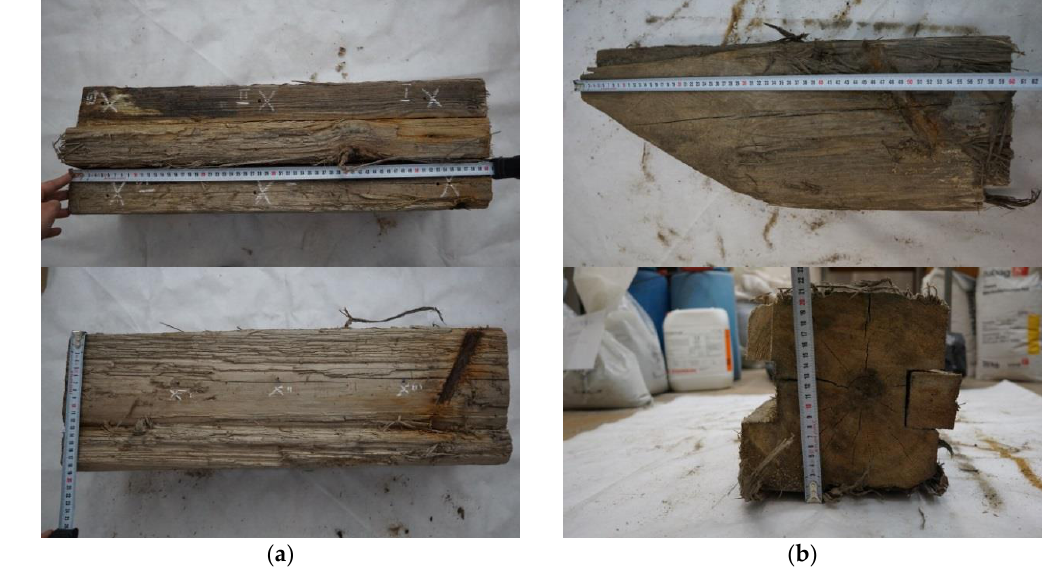
Figure 5. Samples and their dimensions: ( a ) sample 1 cross section 18 cm × 20 cm and length 60 cm, ( b ) sample 3 cross-section 18 cm × 20 cm and length 60 cm with cut.